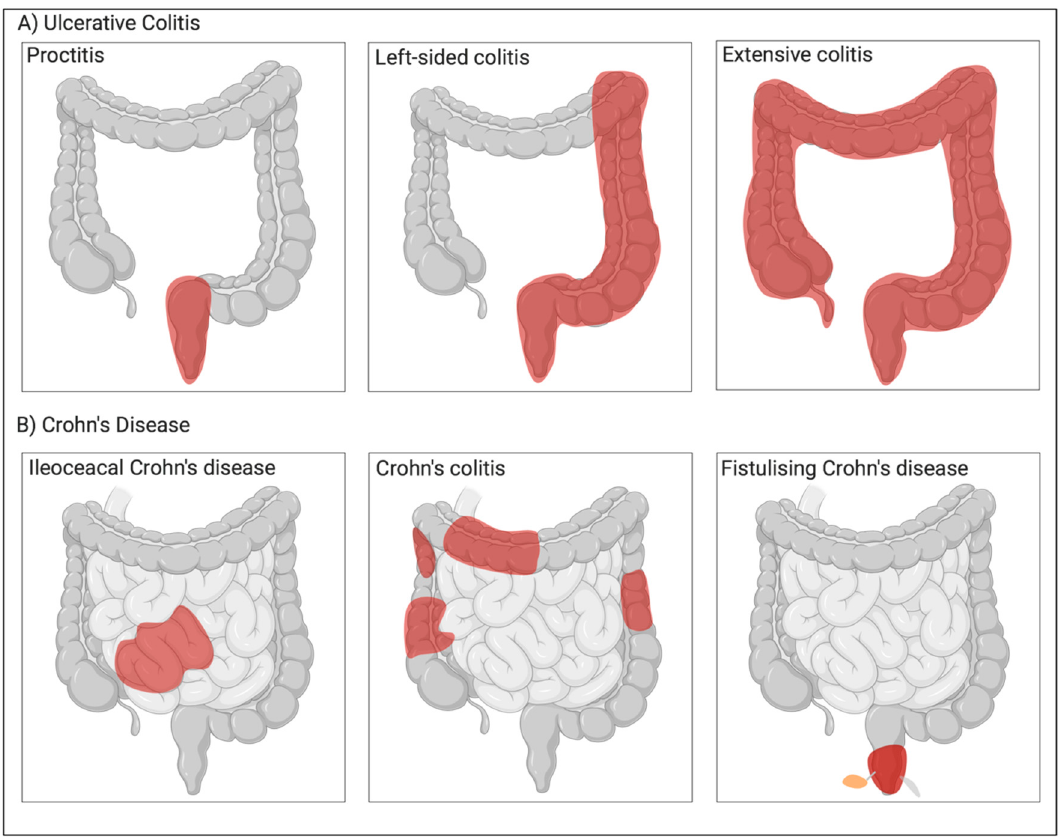
Figure 1. Different types of Inflammatory Bowel diseases. ( A ) Ulcerative colitis: proctitis, left-sided colitis, and extended colitis; ( B ) Crohn’s disease: Ileocecal Crohn’s disease, Crohn’s colitis, and Fistulising Crohn’s disease. Red indicates area of inflammation.